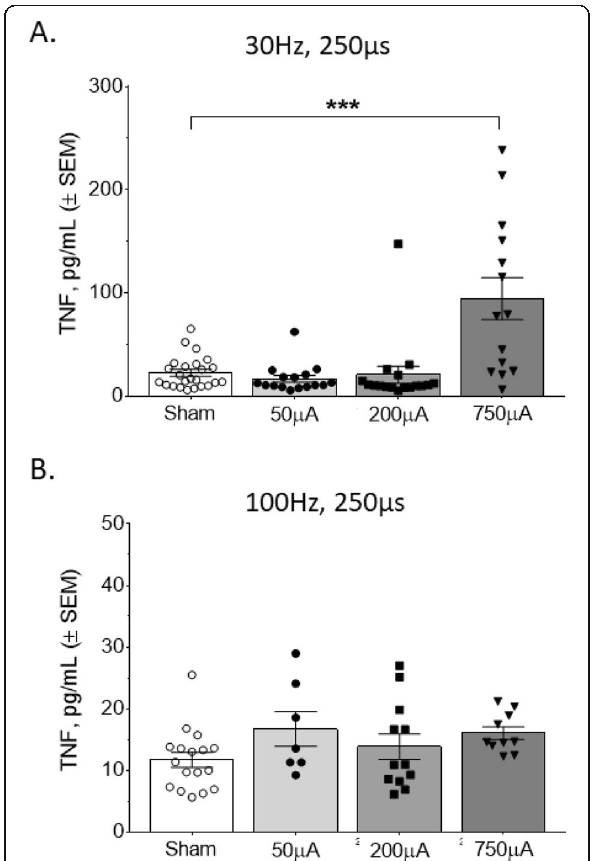
Fig. 3 Serum TNF is significantly increased by vagus nerve stimulation at 250 μ s for a specific parameter combination. a Stimulation resulted in a significant increase in TNF at 30 Hz and 750 μ A pulse amplitude, compared to the sham group. b No significant changes in serum TNF were observed with the 250 μ s pulse width at 100 Hz. Data is represented as individual mouse data points with mean ± SEM. n = 7 – 24 per group, *** P <